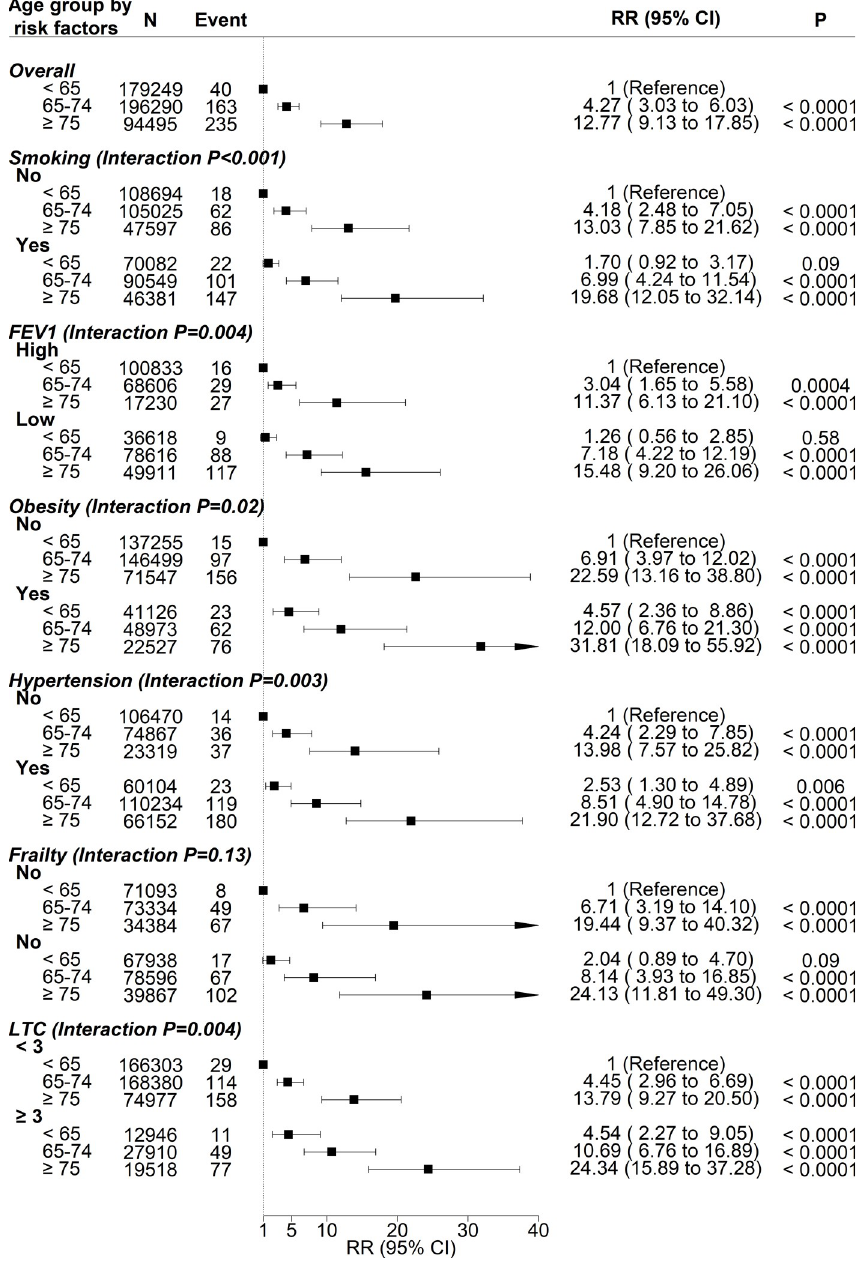
Fig 2. Associations between combinations of age group and risk factors and COVID-19 mortality. Adjusted for sex, ethnicity, deprivation, duration of follow-up; N number; RR relative risk; CI confidence interval; FEV forces expiratory volume; LTC long-term